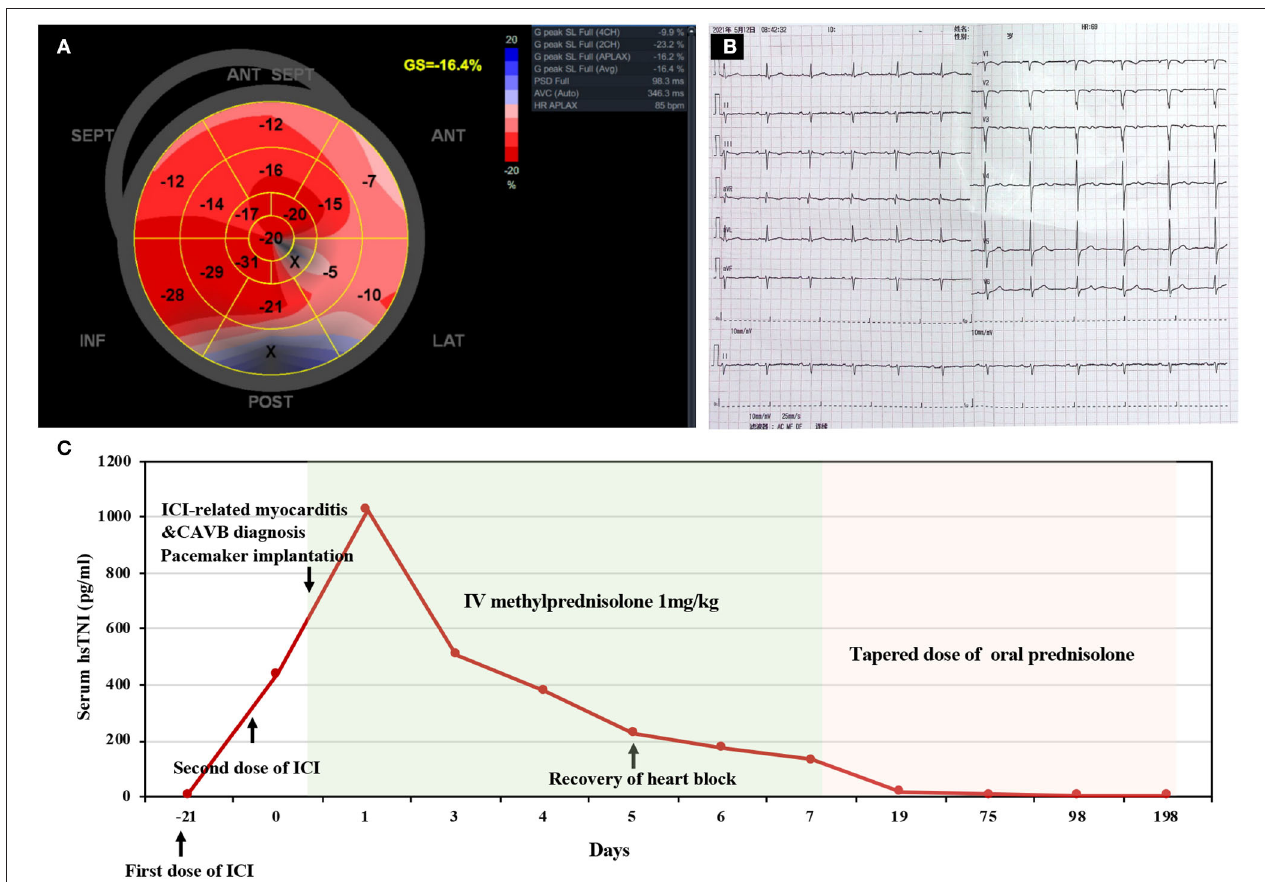
FIGURE 2 | Speckle tracking echocardiography, repeat electrocardiogram, and timeline of disease diagnosis and treatment. (A) Global longitudinal strain (GLS) bull’s-eye plot showed a slightly decreased GLS of − 16.4% and mainly impaired strain in the basal segments of anterior and lateral wall. (B) Electrocardiogram on the 5th day of admission showed sinus rhythm with a normal rate of 69 beats per minute. (C) Timeline of disease diagnosis and treatment. ICI, immune checkpoint inhibitor; CAVB, complete atrioventricular block; IV,